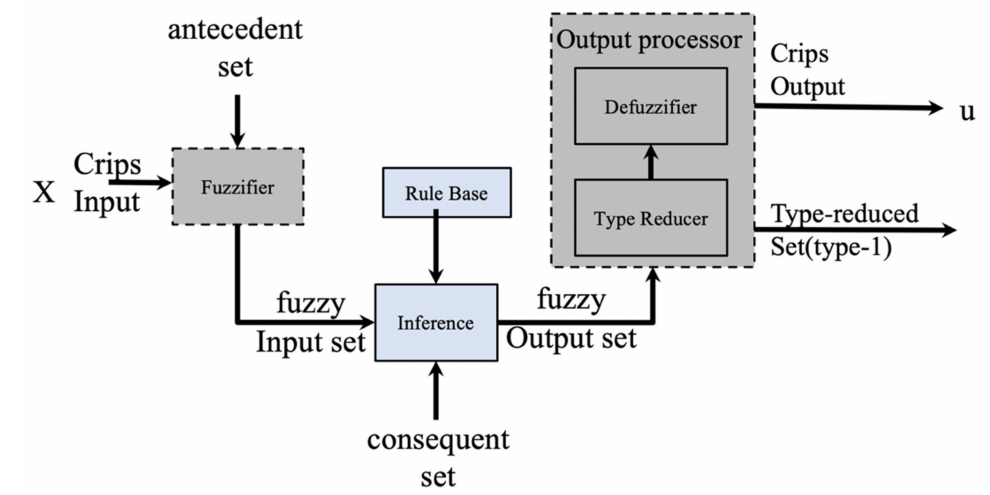
Figure 2. Structure of an